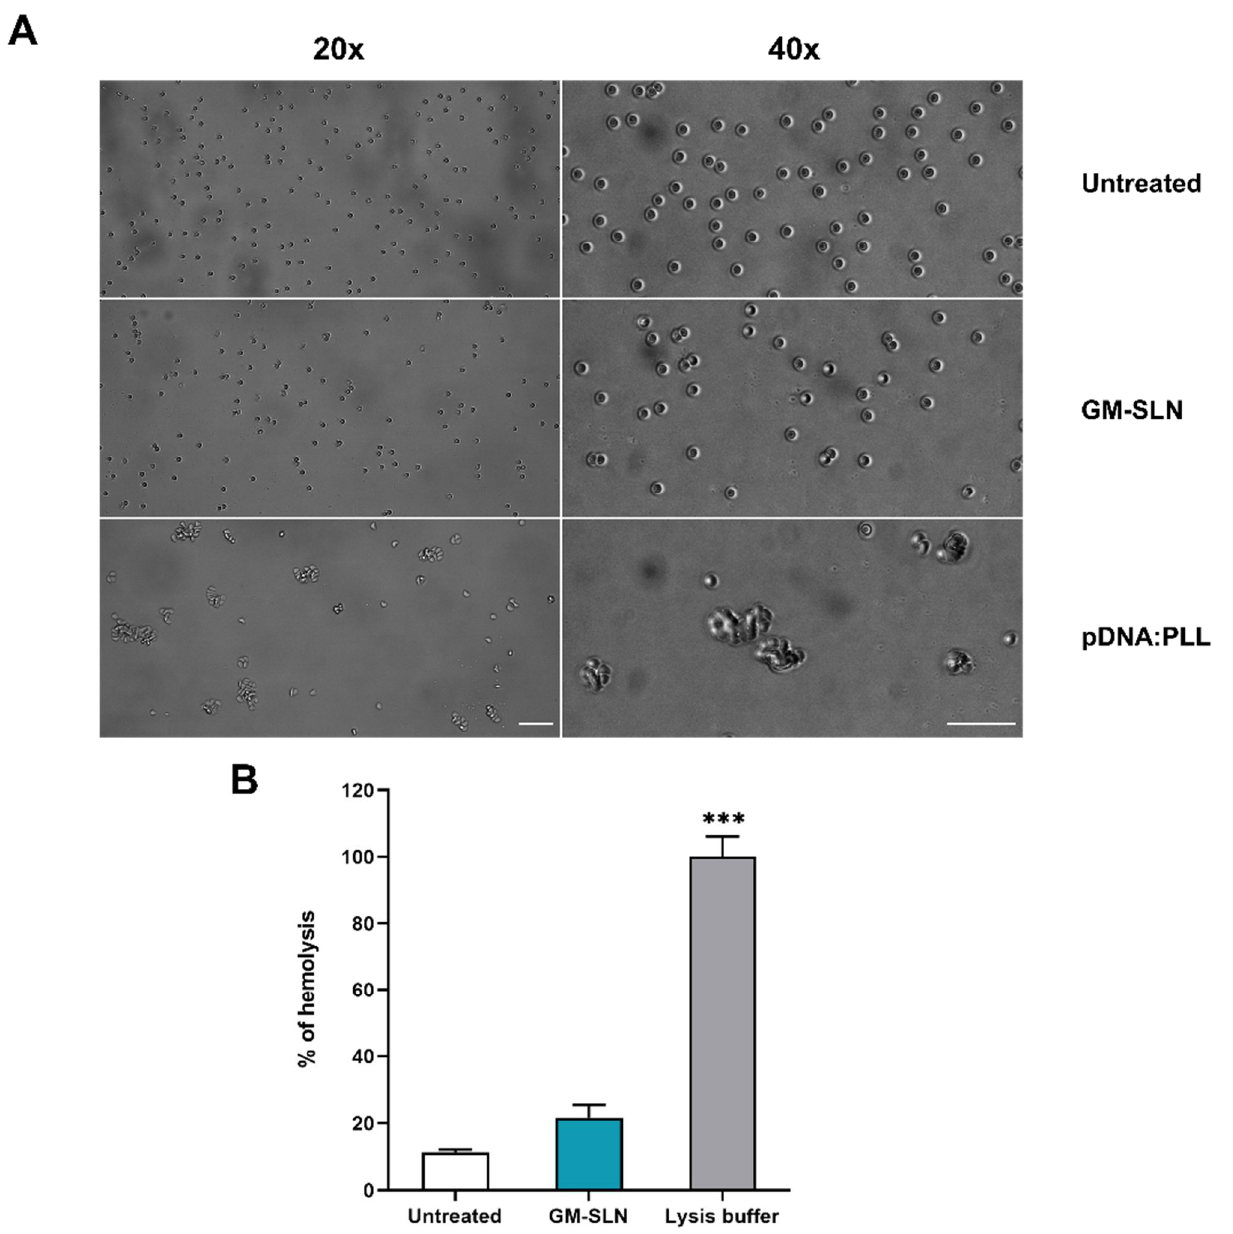
Figure 10. Interaction of GM-SLN with erythrocytes. ( A ) Agglutination of erythrocytes. ( B ) Hemolytic activity. Lysis buffer represents 100% hemolysis sample. Results are shown as the mean ± standard deviation ( n = 3). Scale bars = 50 µm. Statistical significance: *** p < 0.001. GM-SLN: galactomannan SLN-based vector. pDNA: plasmid DNA. PLL: poly-L-lysine.